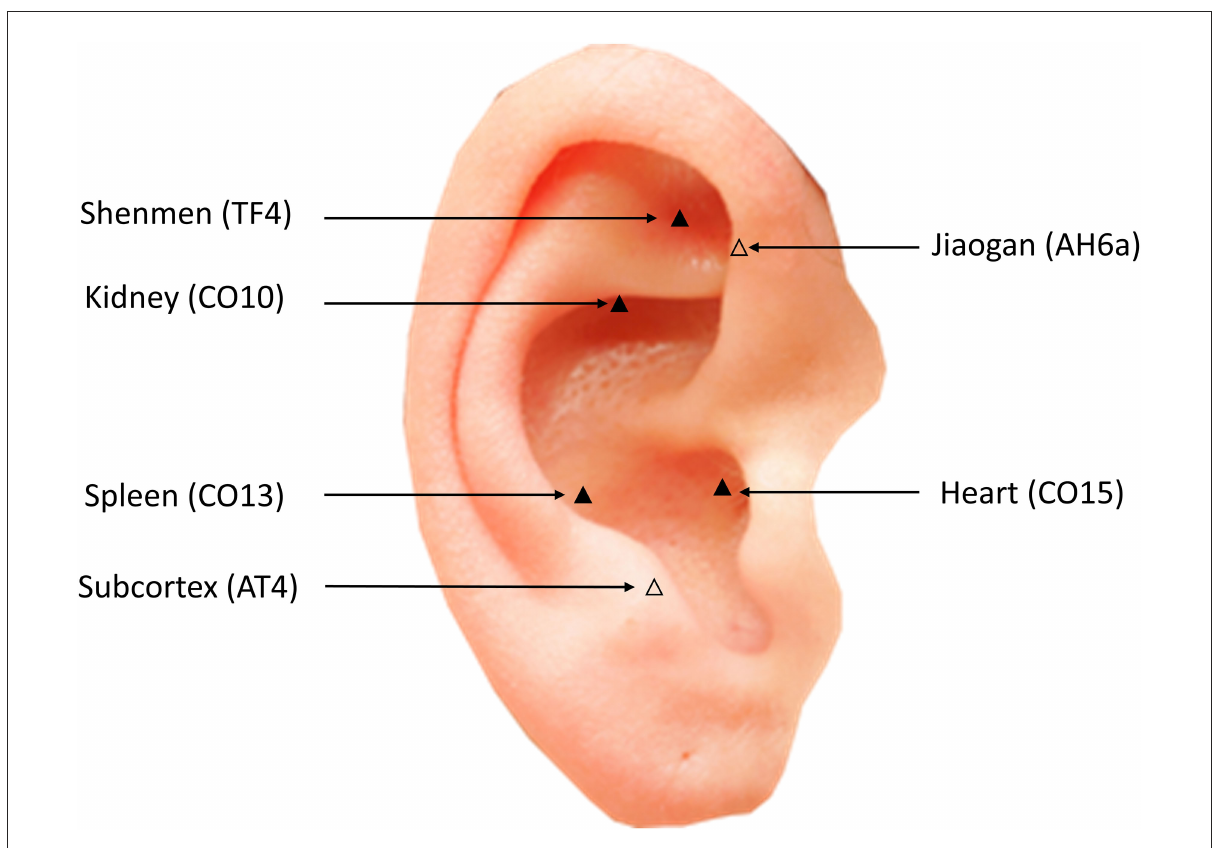
FIGURE2 Location of auricular